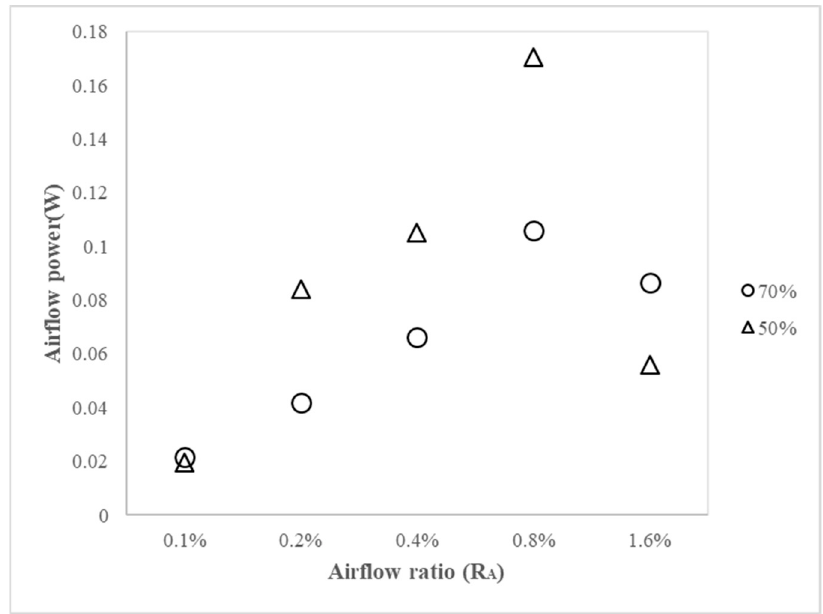
Figure 17. Pneumatic power corresponding to height ratio R Z of OWC chamber.